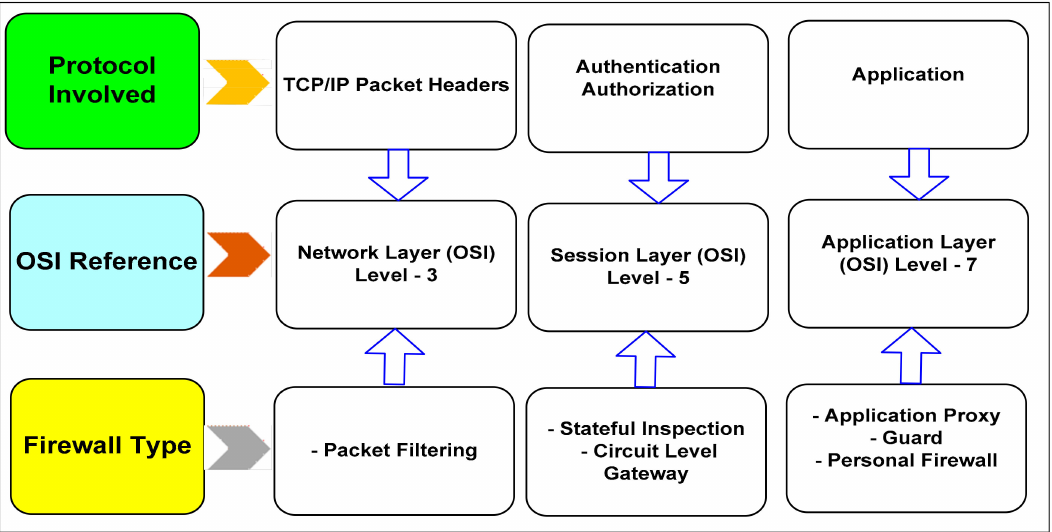
Figure 2. Firewall practice and level of controls according to the OSI reference model.